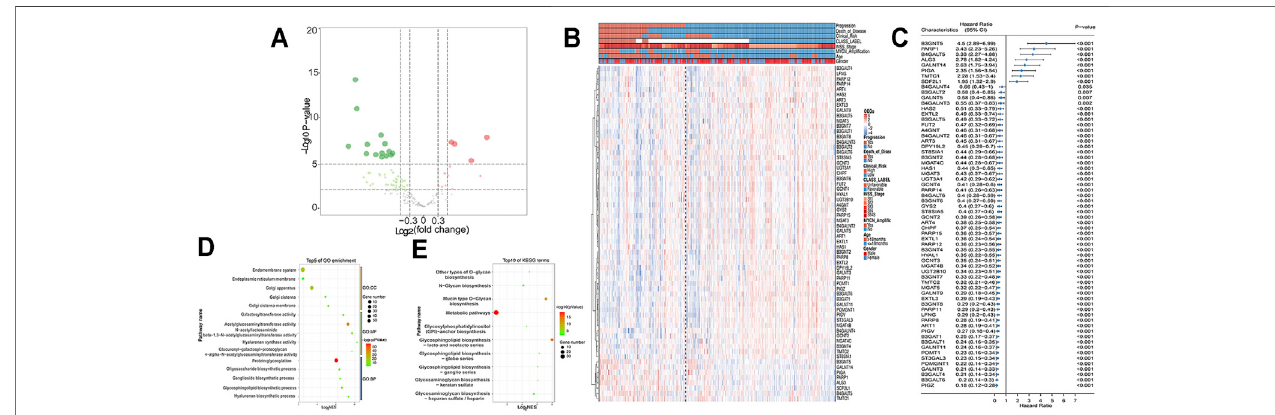
FIGURE2| DEGsinGSE49710 dataset. (A) Volcano plotshows DEGsbetween progressionand nonprogressionNBsamples.Red pointsrepresentupregulated DEGs. Green points denote downregulated DEGs. Gray points denote genes with no signi fi cant differences. (B) Heat map showing the association between 64 DEGs and clinical characteristics annotated on the top. (C) Forest plot of univariate Cox regression results of DEGs. GO (D) and KEGG (E) analyses of DEGs.